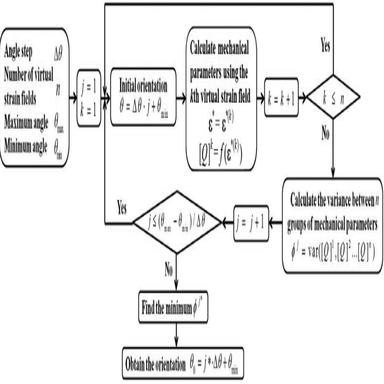
Flowchart of the OIVFM.